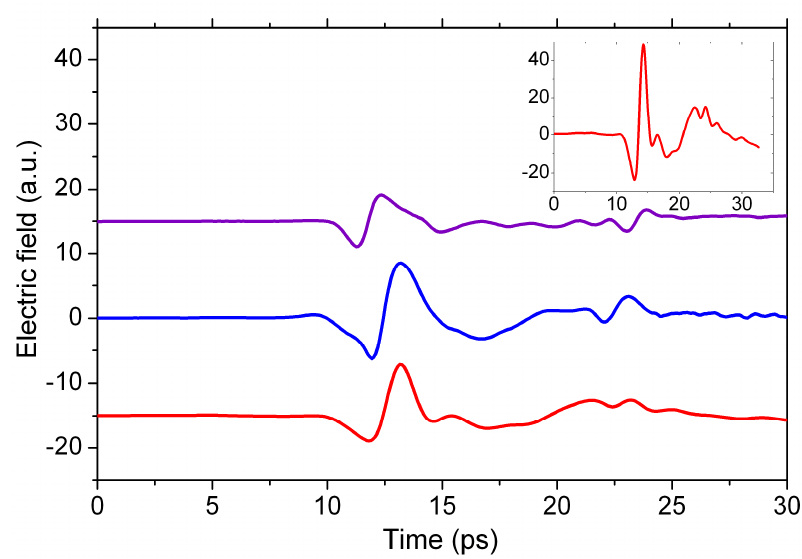
Figure 5. Detected time-domain signal traces: violet line LT-InGaAs/GaAs(100) U b = 3.7 V, blue line LT-InGaAs/GaAs (111)A U b = 3.7 V, red line LT-InGaAs/InAlAs/InP(111)A U b = 3.7 V, (inset) LT-InGaAs/InAlAs/InP(111)A U b = 25 V.